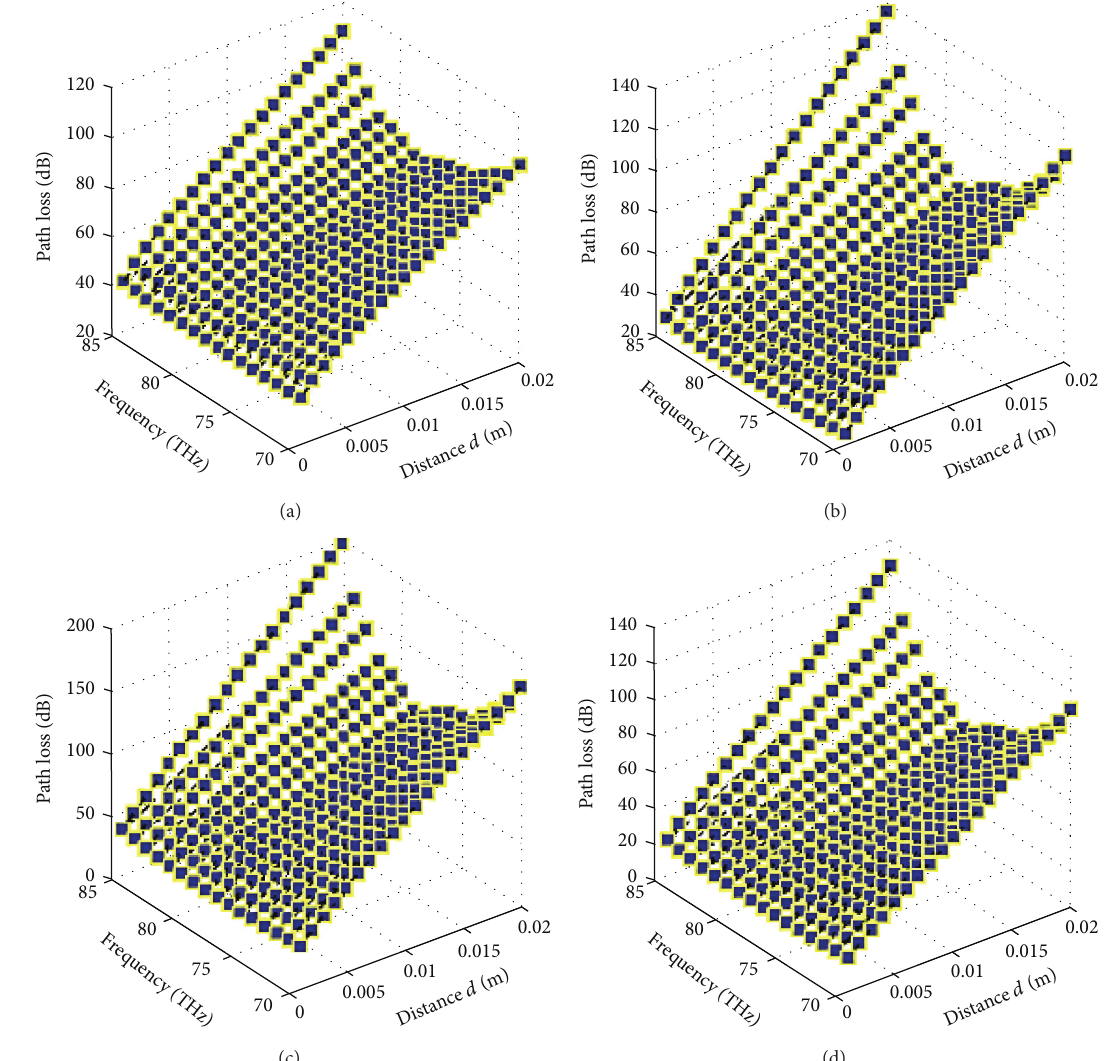
Figure 10: Path loss versus operating frequency and transmission distance in mixtures (a), (b), (c), and